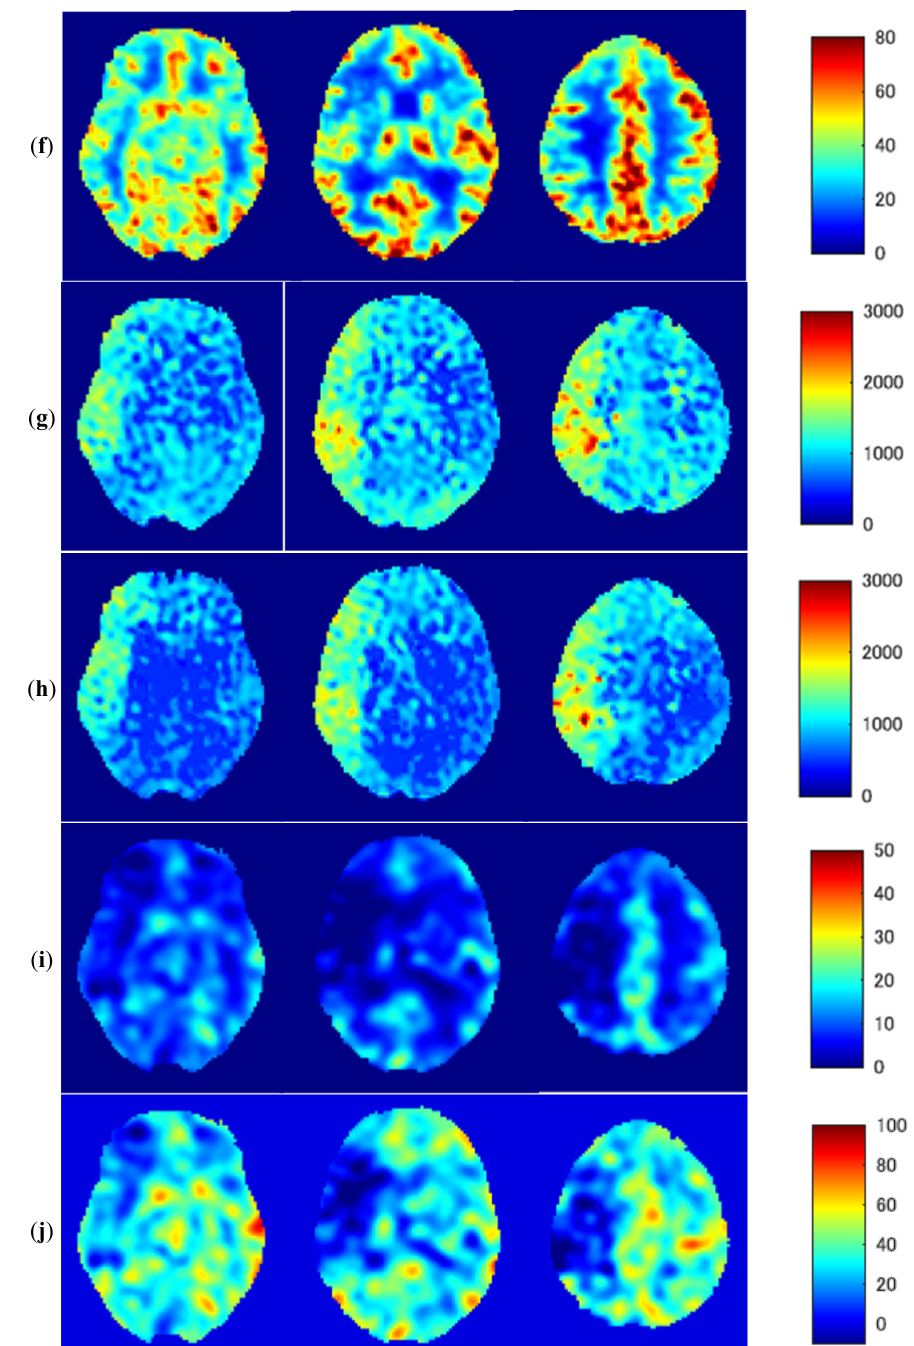
Figure 5. Representative images of a 46 ‐ year ‐ old woman with severe Moyamoya disease (patient No. 6). T2 ‐ weighted MR image ( a ), MR angiography ( b ), baseline ASL ‐ CBF ( c ), post ‐ ACZ ASL ‐ CBF ( d ), baseline PET ‐ CBF ( e ), post ‐ ACZ PET/CBF ( f ), baseline ASL ‐ ATT ( g ), post ‐ ACZ ASL ‐ ATT ( h ), Δ PET ‐ CBF ( i ), and CVR ( j ) CVR; cerebrovascular reactivity. ( d ), baseline PET-CBF ( e ), post-ACZ PET/CBF ( f ), baseline ASL-ATT ( g ), post-ACZ ASL-ATT ( h ), ∆ PET-CBF ( i ), and CVR ( j ) CVR; cerebrovascular